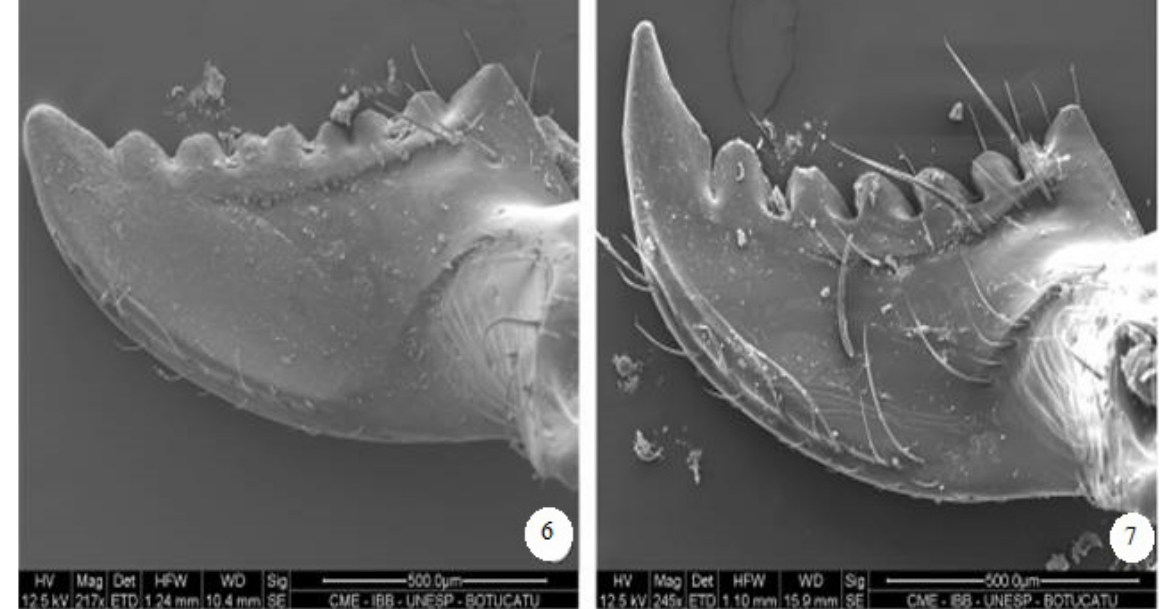
Figs 6-7 . ventral side of right mandiblesof Atta bisphaerica (6) and Atta sexdensrubropilosa (7)